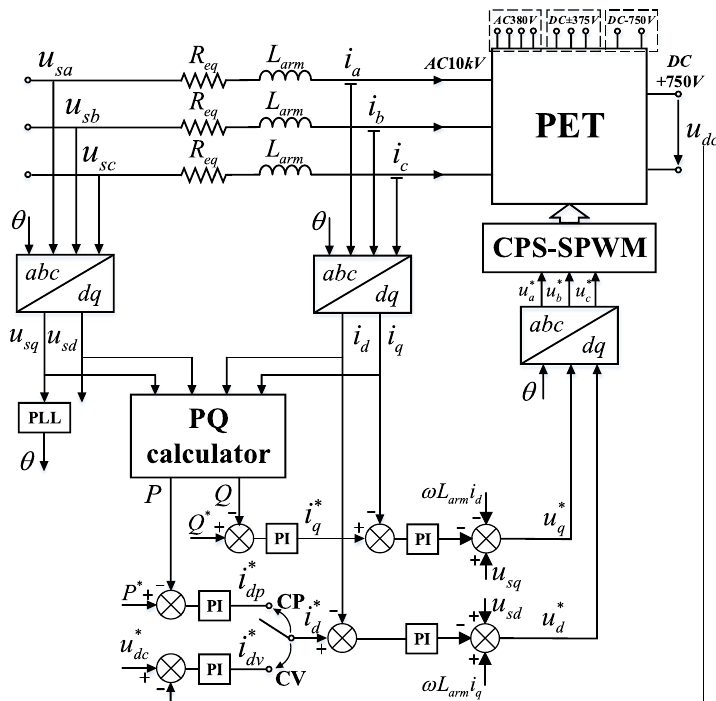
Fig. 4 Steady state control schematic diagram of